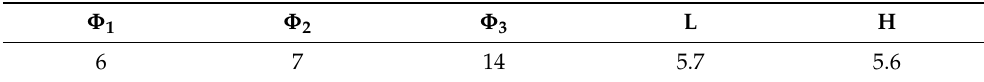
Table 2. Stirring tool size.